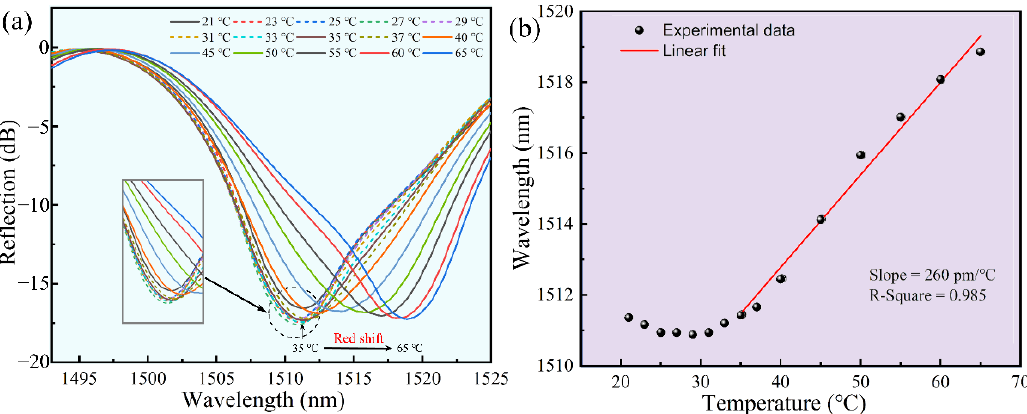
Figure 8. Temperature response of the polymer fixed-supported bridge (~1510 nm). ( a ) Reflection spectrum evolution of the polymer fixed-supported bridge while the temperature increases from 25 ℃ to 55 ℃ . ( b ) Data and a linear fit of the dip wavelength versus temperature from 35 ℃ to 65 ℃ .